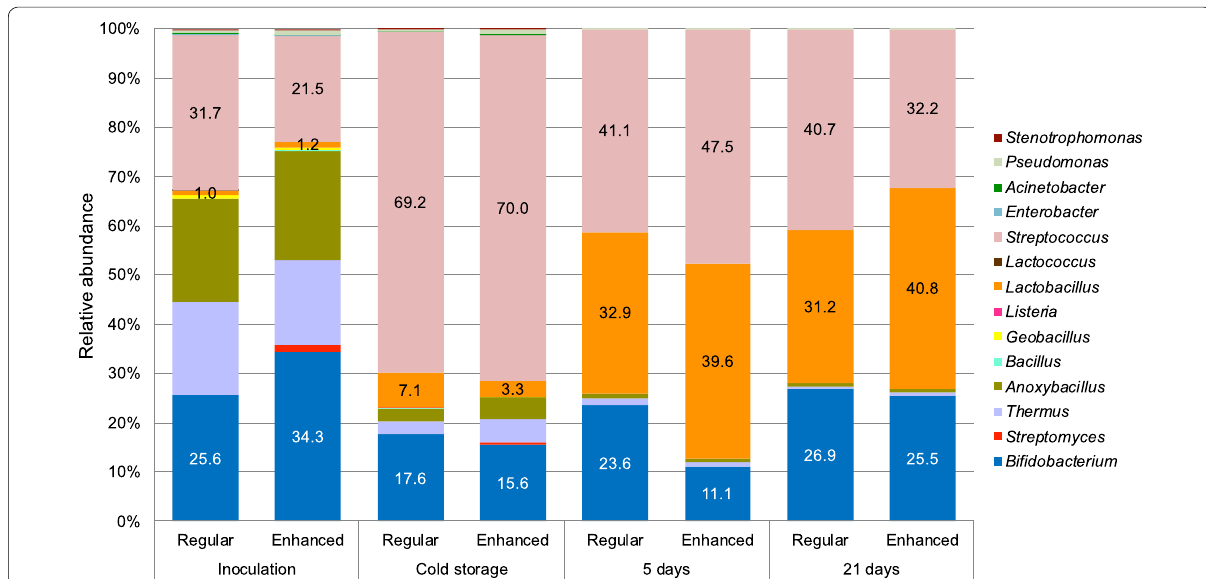
Fig. 2 The relative abundance (%) of genera in yoghurt produced using sweetness-enhanced (enhanced) and regular milk using the probiotic ABT-100 culture. The relative abundances of the starter culture genera ( Streptococcus , Lactobacillus and Bifidobacterium ) are